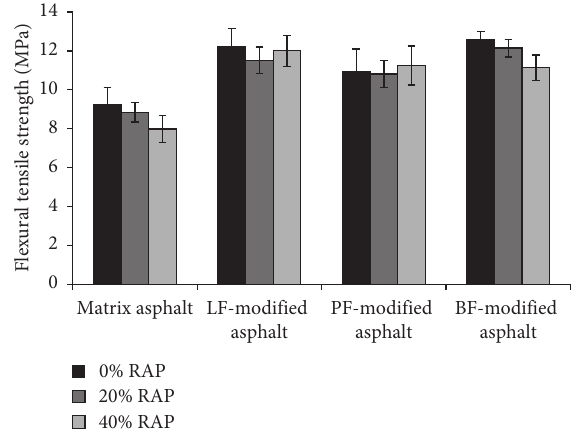
Figure 5: Flexural tensile strength results of different asphalt mixtures.